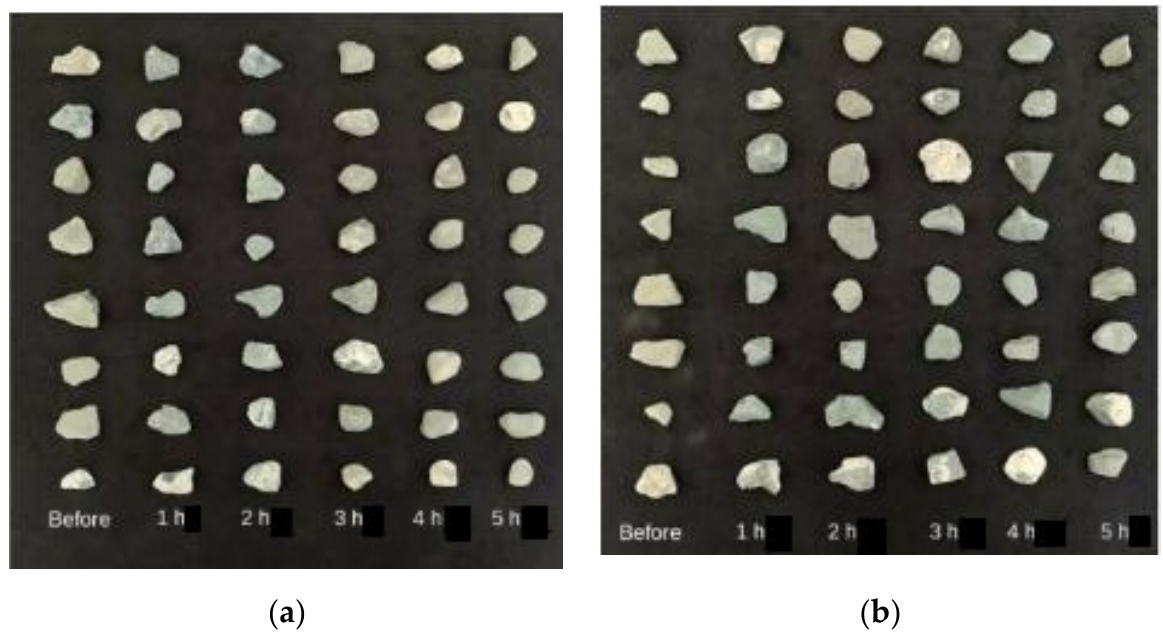
Figure 3. Visual changes in geometry of RCA: ( a ) 4/10 mm; ( b ) 8/20 mm subjected to mechanical treatment for up to 5 h.